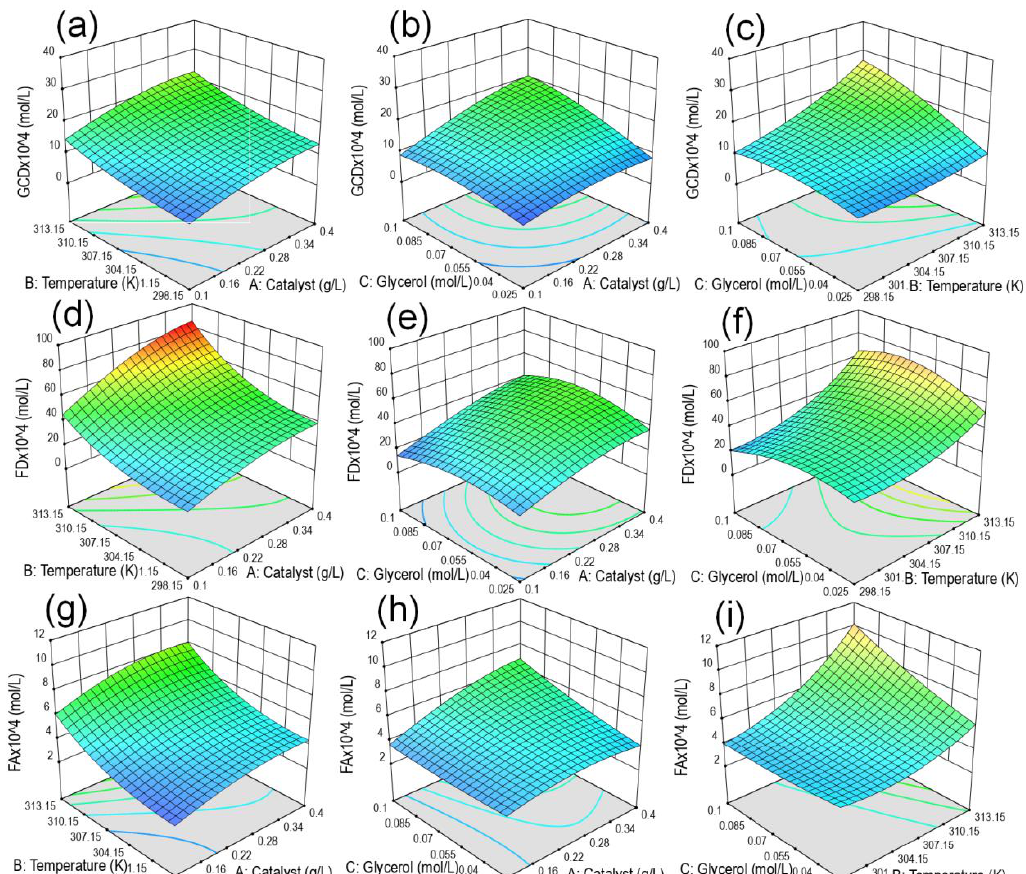
Figure 16. Response surface plots for all possible combinations when two independent variables change and the other variable remains constant at the center point. ( a , d , g ) show the change in reaction temperature and catalyst amount with a constant glycerol concentration. ( b , e , h ) show the variation in glycerol concentration and catalyst amount with a constant reaction temperature. ( c , f , i ) show the change in glycerol concentration and reaction temperature with a constant catalyst amount. Table 5. Optimum and experimental values of the response variables.